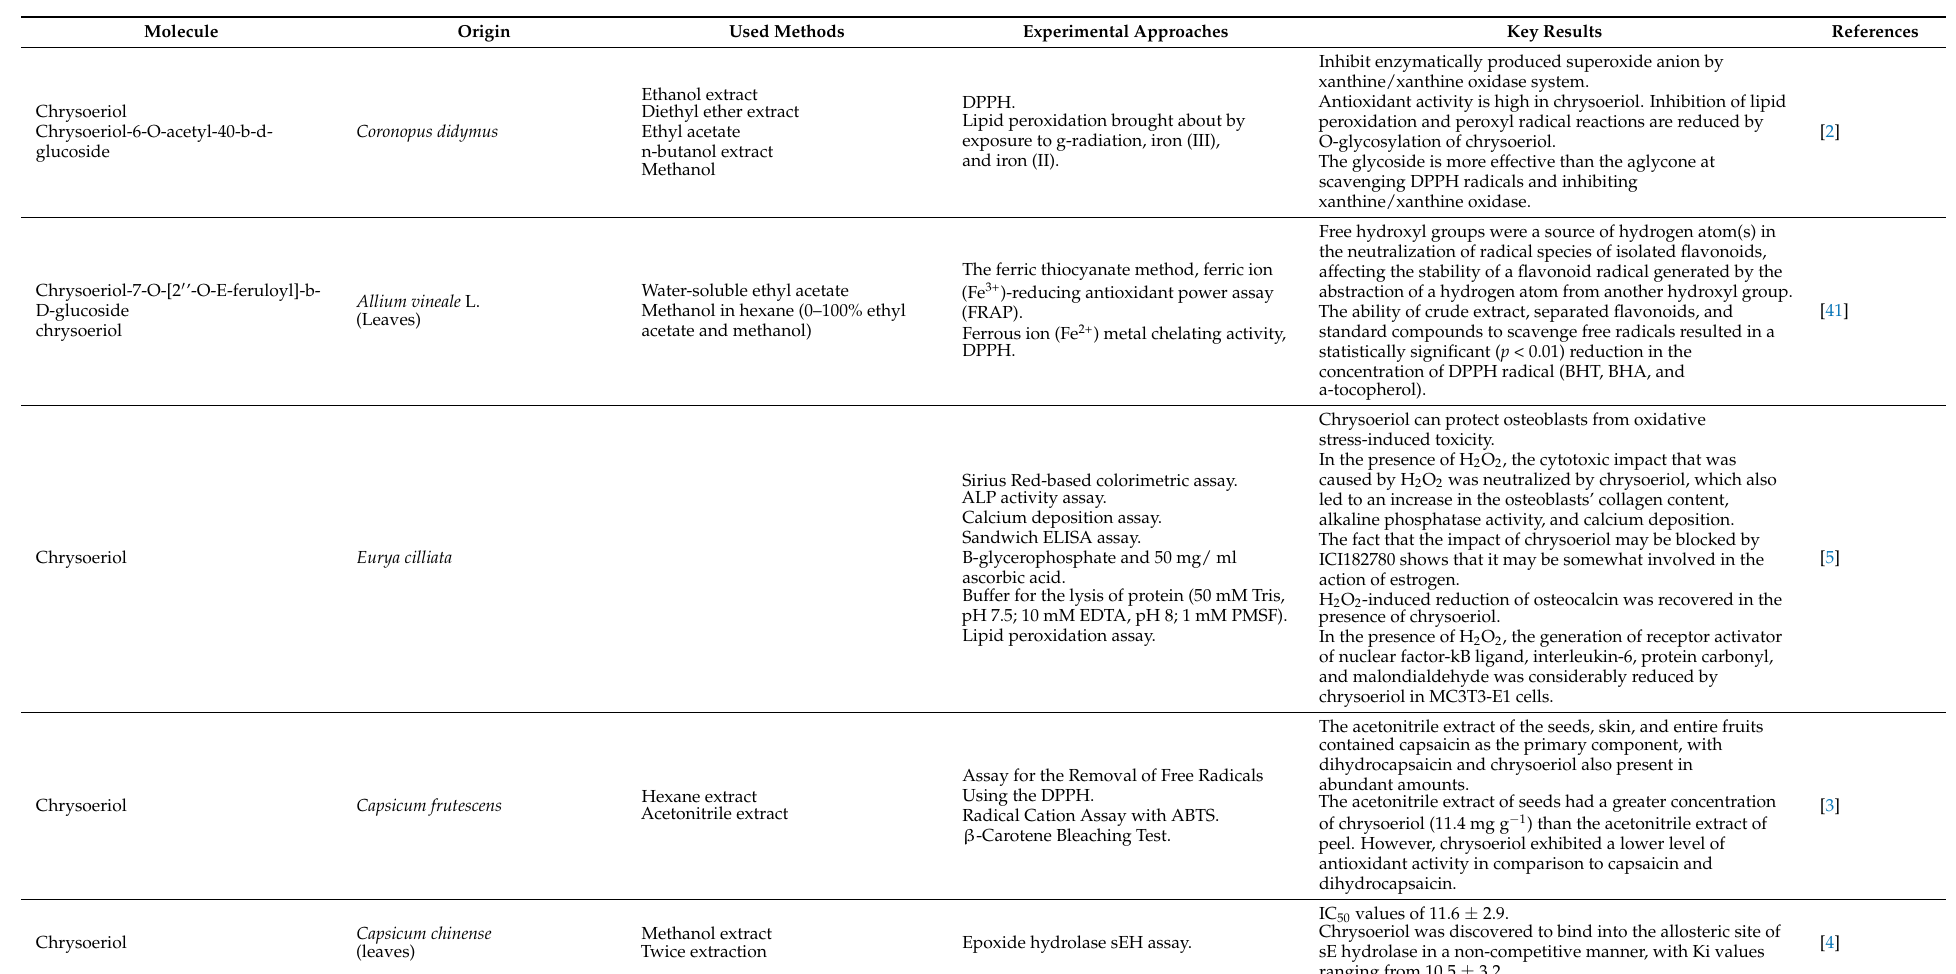
Table 5. Antioxidant activities of